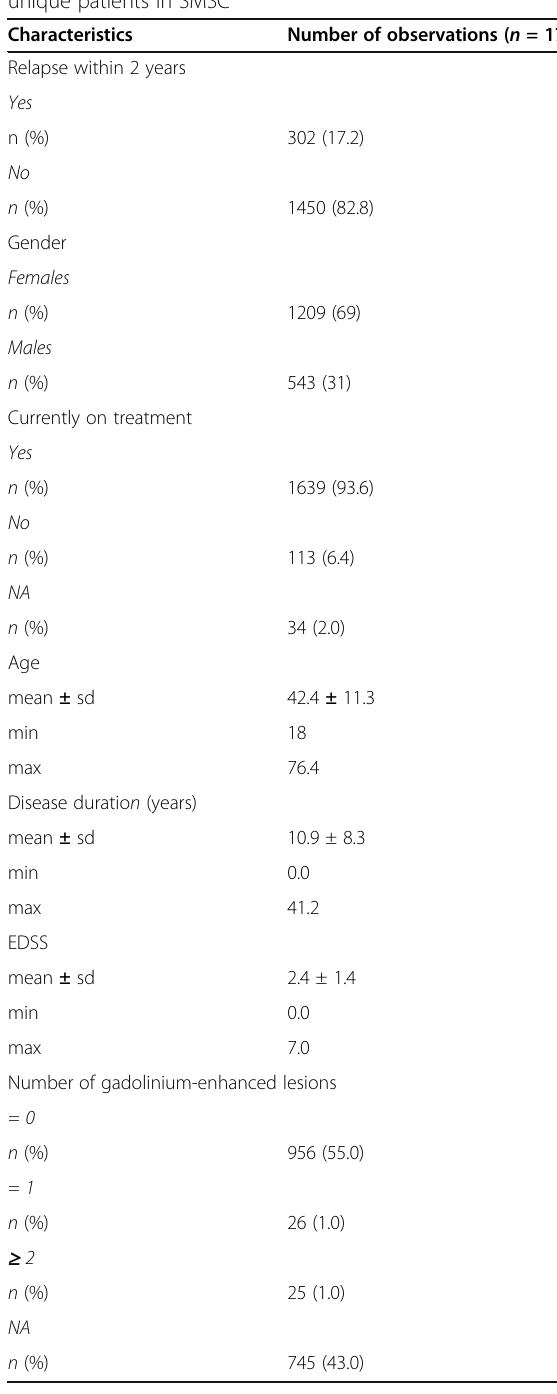
Table 1 Summary statistics of some important baseline characteristics using all 1752 2-year cycles coming from 935 unique patients in